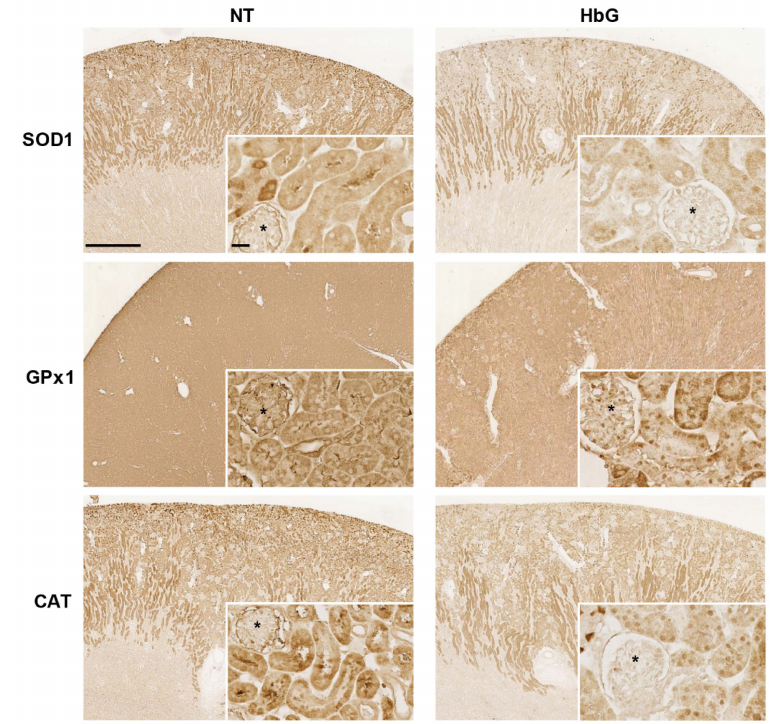
Figure 3. Immunohistochemical analysis of SOD1, GPx1, and CAT protein expression. Kidney sections from sham controls and 4 h (SOD1 and CAT) or 12 h (GPx1) post-ET with HbG were probed as described in the Materials and Methods. Reduced immunoreactivity (brown signal) was observed for all three enzymes in the HbG group compared to NT. Asterisks denote glomeruli. Scale bars: 1 mm (main panels) or 25 µ m